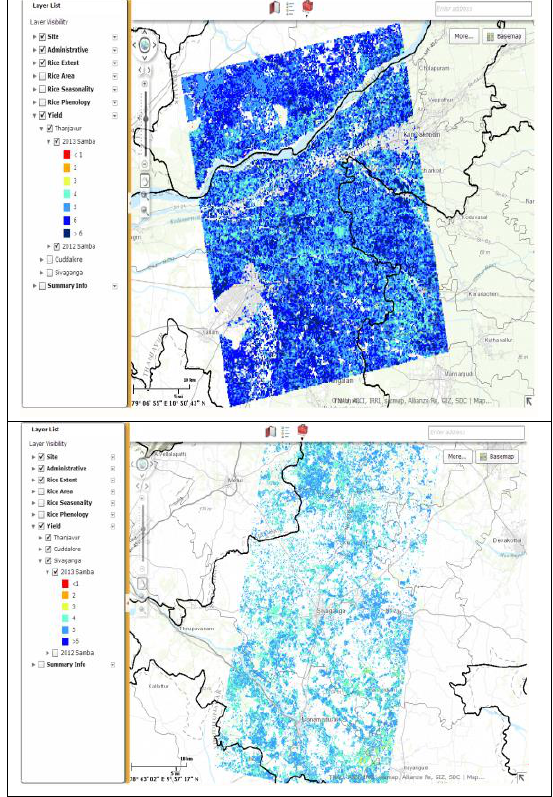
Figure.6.Rice yield map of Thanjavur and Sivaganga 2013